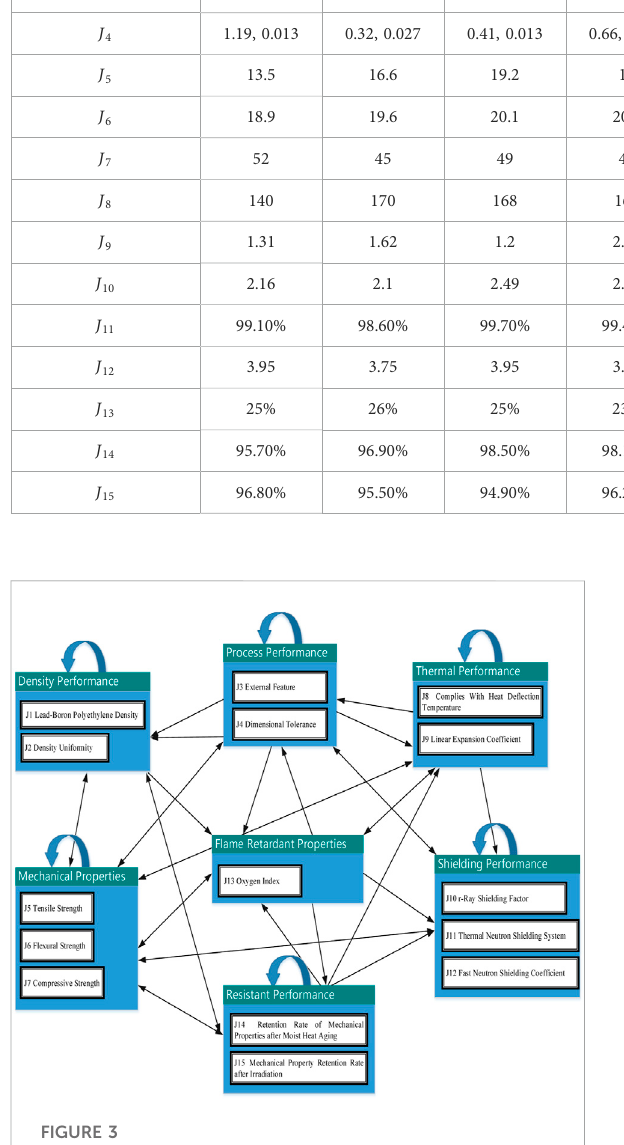
FIGURE 3 ANP network structure of composite shielding material performance evaluation.